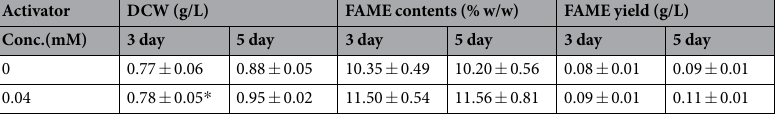
Table 3. Total dry cell weight, lipid contents, and lipid yields of C . reinhardtii grown under various concentrations of C6 ceramide. Data are expressed as mean ± SD (n = 3). Significant differences, as determined by Student’s t-test, are indicated by an asterisk ( * P < 0.05, ** P < 0.01, *** P < 0.001).